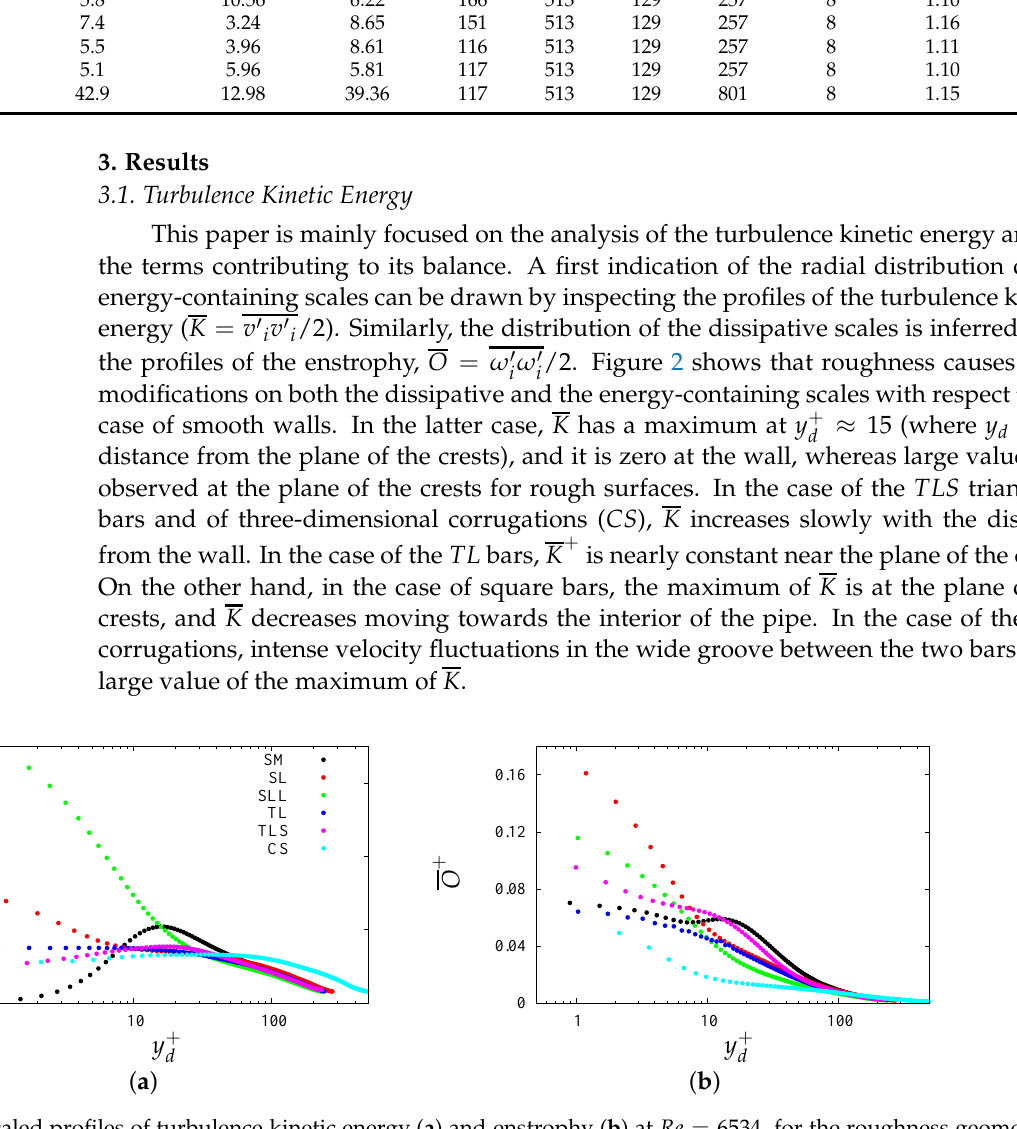
Figure 2. Inner-scaled profiles of turbulence kinetic energy ( a ) and enstrophy ( b ) at Re = 6534, for the roughness geome- tries given in the legend of panel ( a